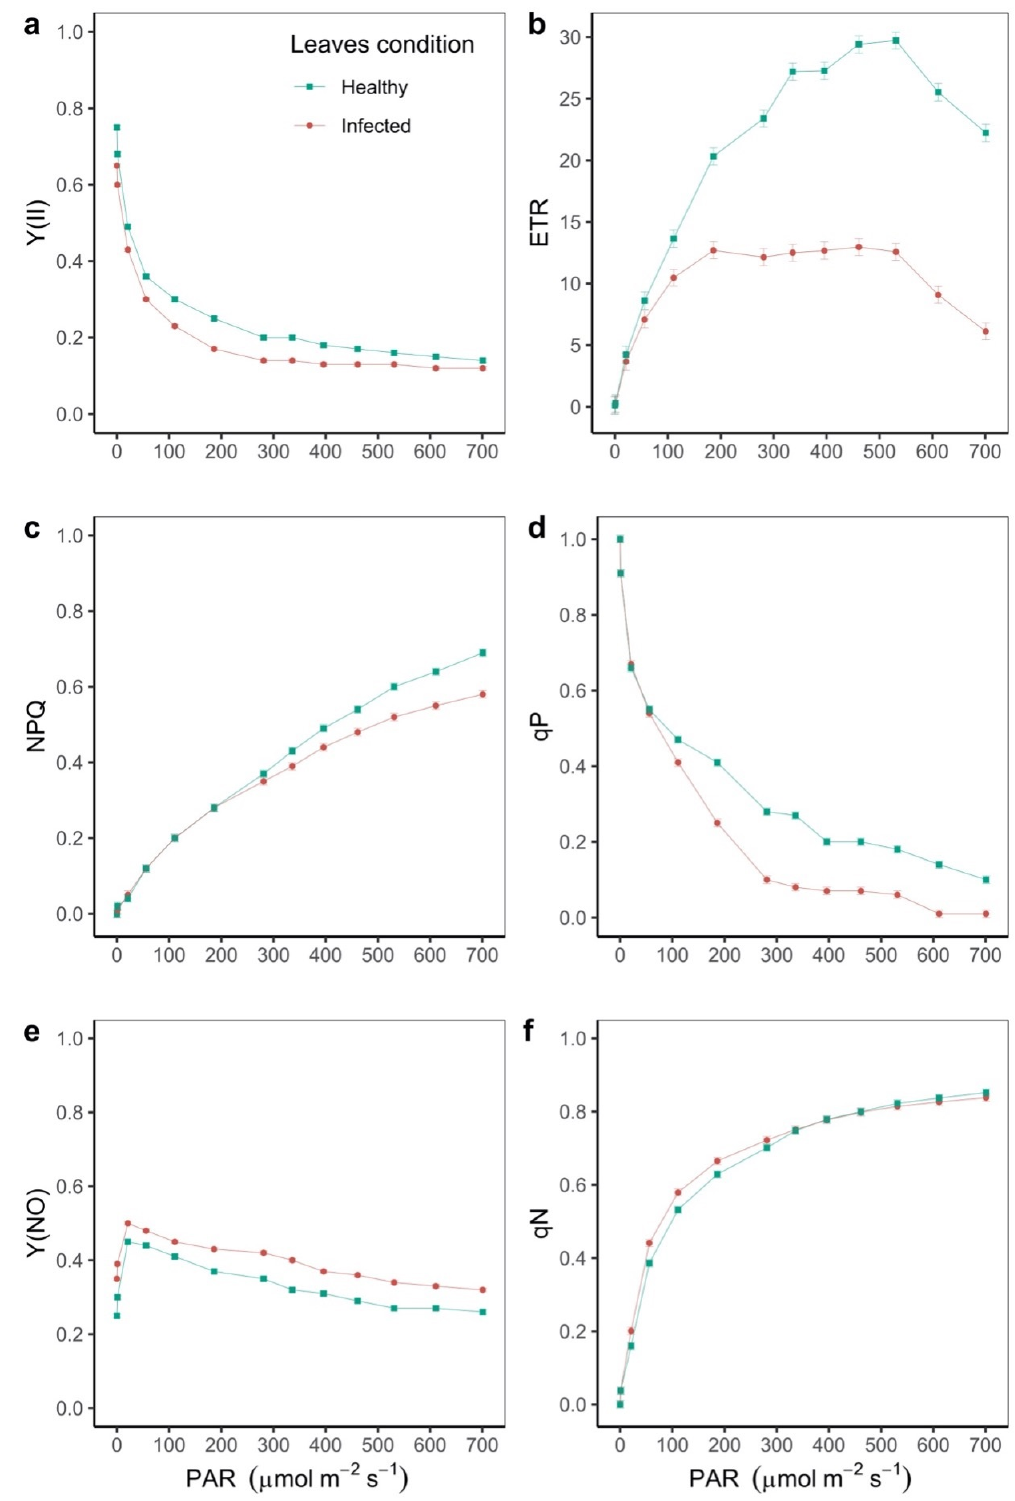
Figure 2. Response of the photosynthetic apparatus to disease stress. ( a ) The effective quantum yield of photochemical energy conversion in PSII (Y(II)); ( b ) non-photochemical quenching (NPQ); ( c ) the quantum yield of non-regulated energy dissipation (Y(NO)); ( d ) the apparent electron transport rate (ETR); ( e ) the coefficient of photochemical quenching (qP); ( f ) the non-photochemical quenching coefficient (qN). PAR: photosynthetically active radiation. Each data point on the curve represents the mean and standard deviation (n = 708 plants for each leaf condition).